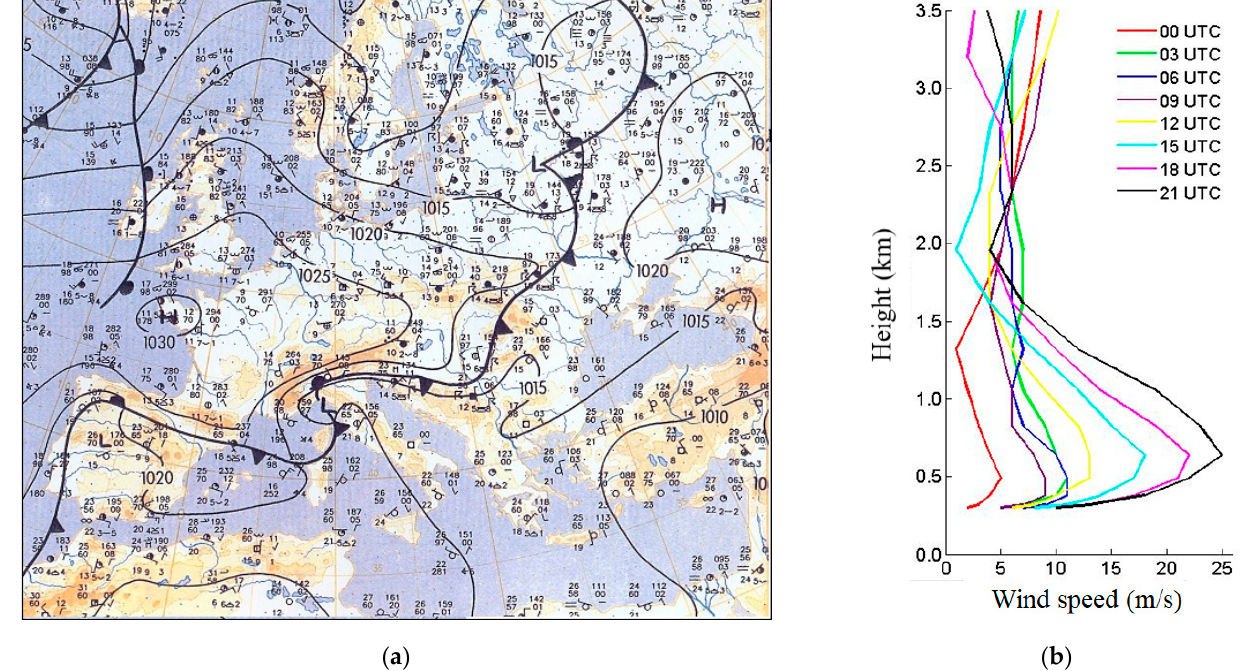
Figure 4. ( a ) Mean sea level pressure analysis over Europe ( Deutscher Wetterdienst , DWD) on 11 August 2001 at 00 UTC, and ( b ) wind speed vertical profile (ms − 1 ) at Split-Marjan meteorological station on the same day, simulated from the numerical mesoscale ALADIN model [91].